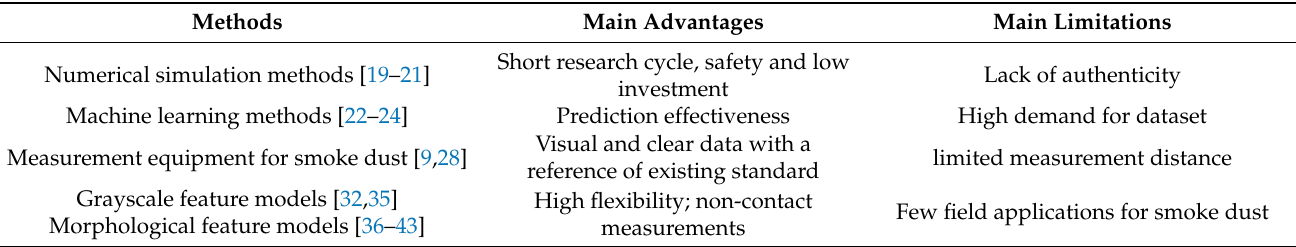
Table 1. Comparation of previous studies on analysis of smoke